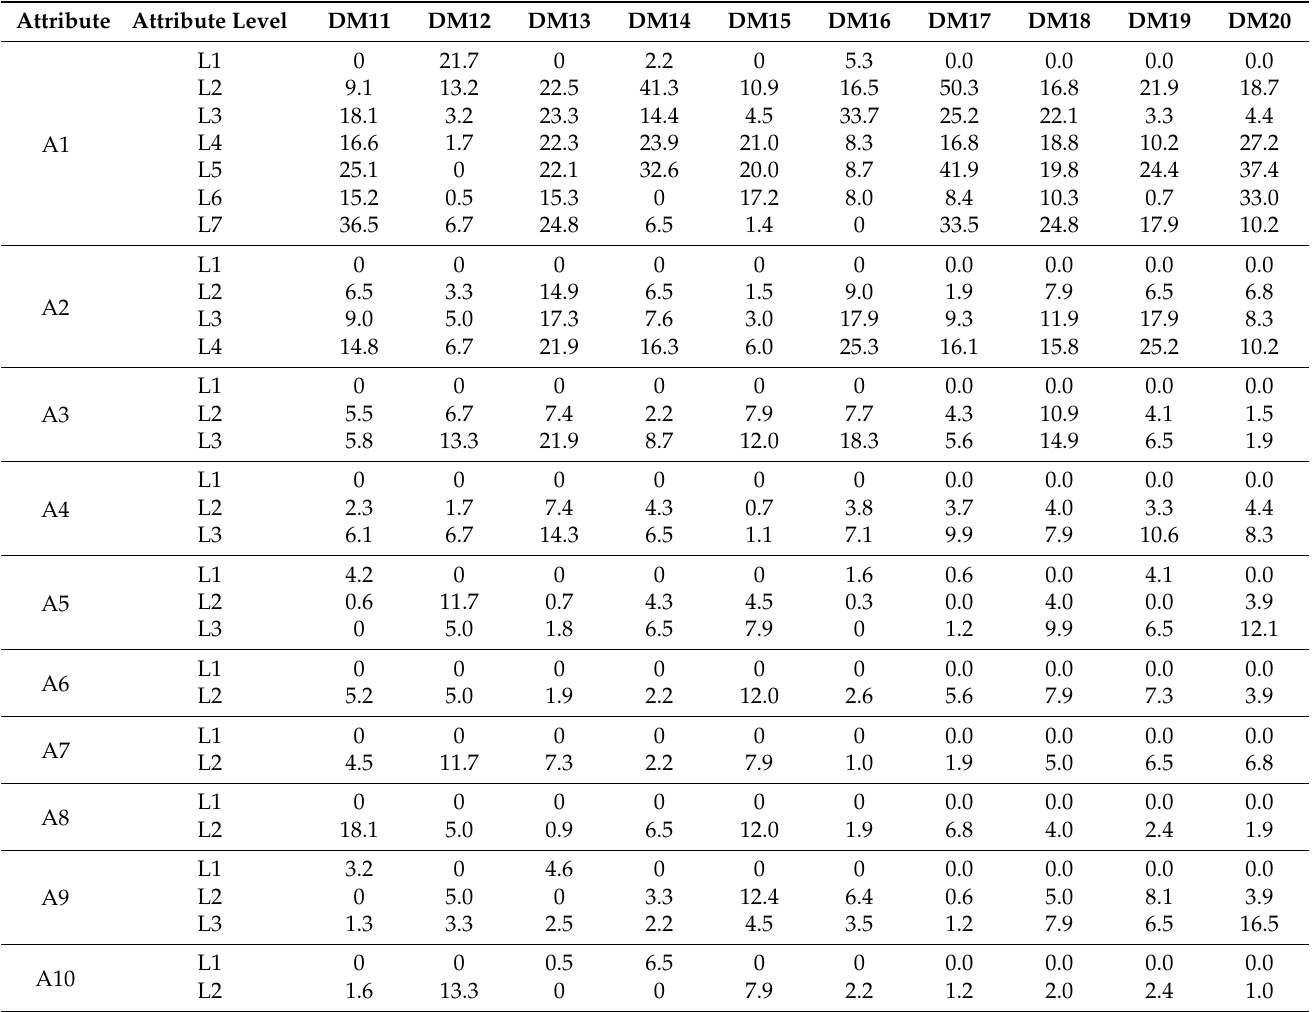
Table A5. Weighting of attribute level by respondent, presented as a %. DM11–20, respondent code. For definitions of attributes and levels, see Table